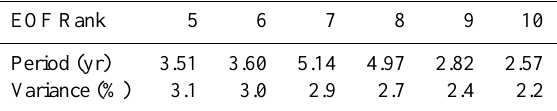
Table 1. AMOI(ENSO) EOFs with dominant frequencies in the ENSO band (2 to 7yr) that contribute coherent power from the MEI to AMOI.